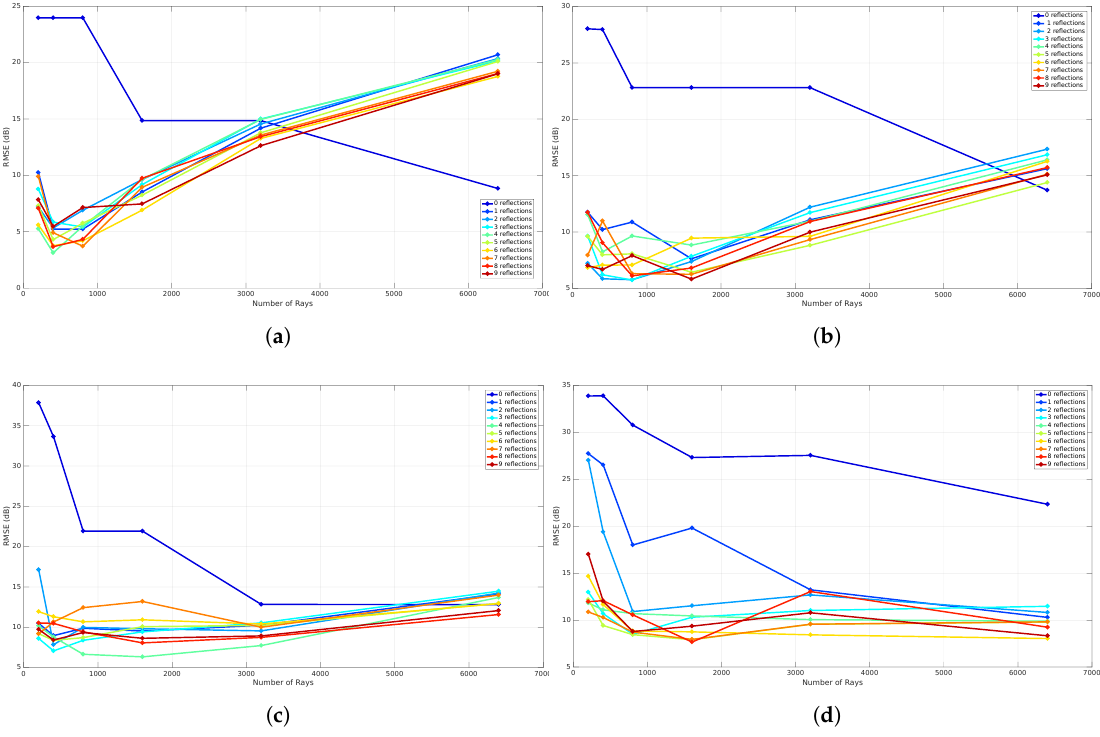
Figure 27. Reflection benchmark for office environment 2. ( a ) reflection benchmark at level 6; ( b ) reflection benchmark at level 7; ( c ) reflection benchmark at level 8; ( d ) reflection benchmark at level